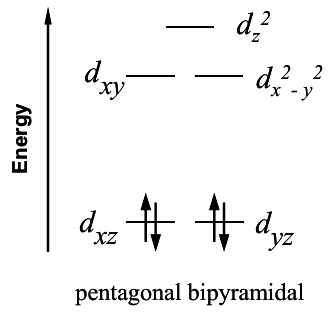
Figure 4. The qualitative d-orbital energy-splitting diagram for pentagonal bipyramidal geometry and the ground-state electronic configuration of 1 .